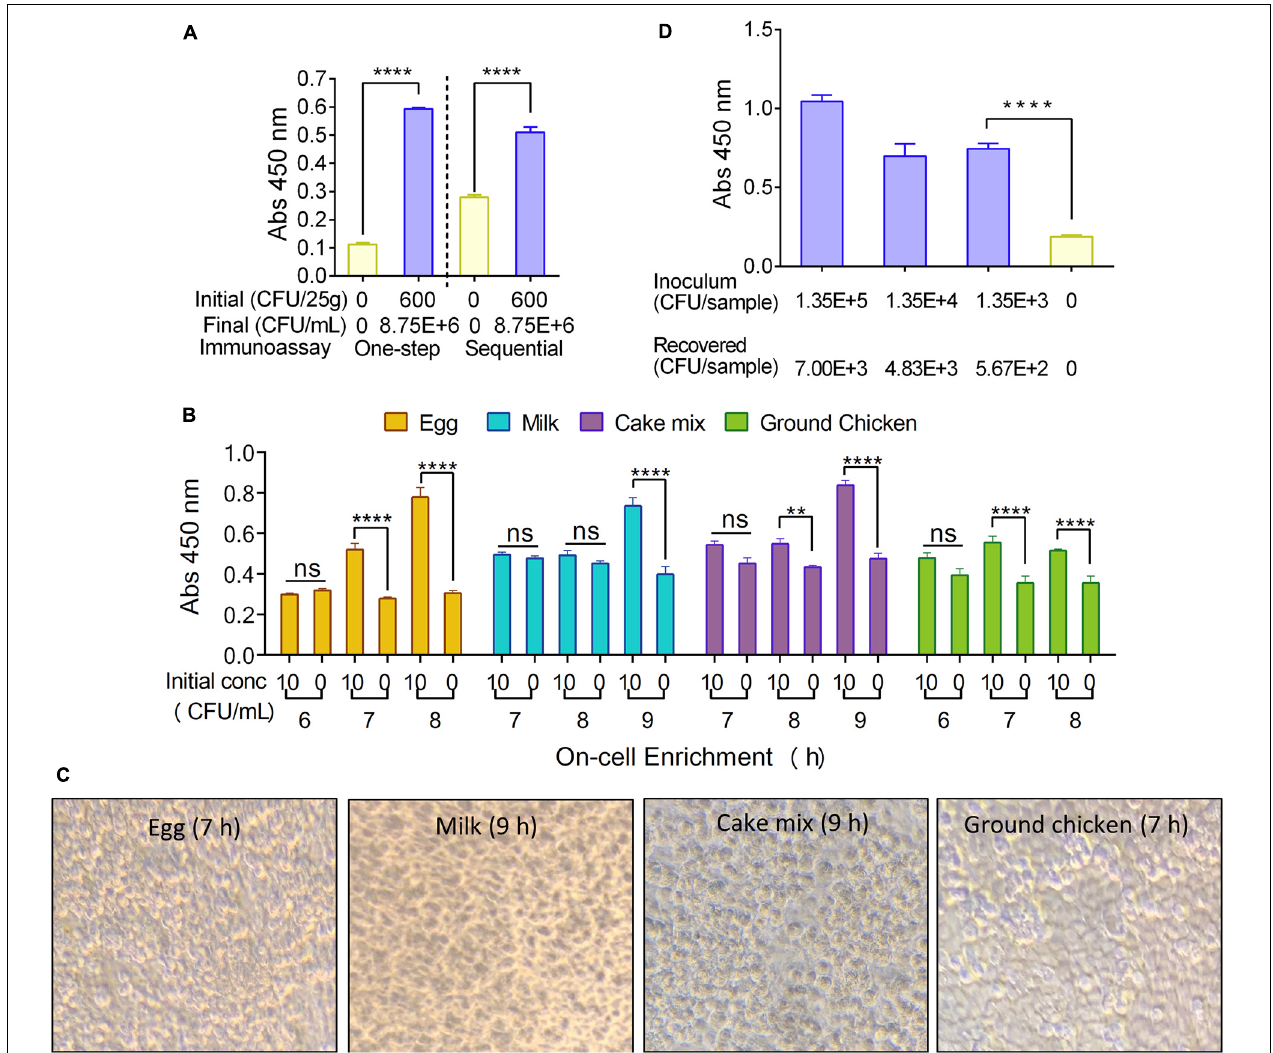
FIGURE 5 | Mammalian cell-based immunoassay assay optimization. (A) One-step antibody probing vs sequential antibody probing against a bacterial cell concentration of 8.75 × 10 6 CFU/ml of S . Enteritidis. (B) Analysis of time (h) required for positive MaCIA result during on-cell enrichment of S. Enteritidis PT21 ( ∼ 10 CFU/mL) inoculated into different food products. (C) Light microscopic images of formalin-fixed HCT-8 cell monolayers after on-cell enrichment for 7–9 h. Magnification (400 × ). (D) MaCIA analysis of skin swab samples after on-cell enrichment (7 h). Samples with higher concentrations were also significantly ( P < 0.001) different than the negative control. Error bars represent SEM. **** P < 0.0001; ** P < 0.01; ns, no significance. Cut-off for positive: P <